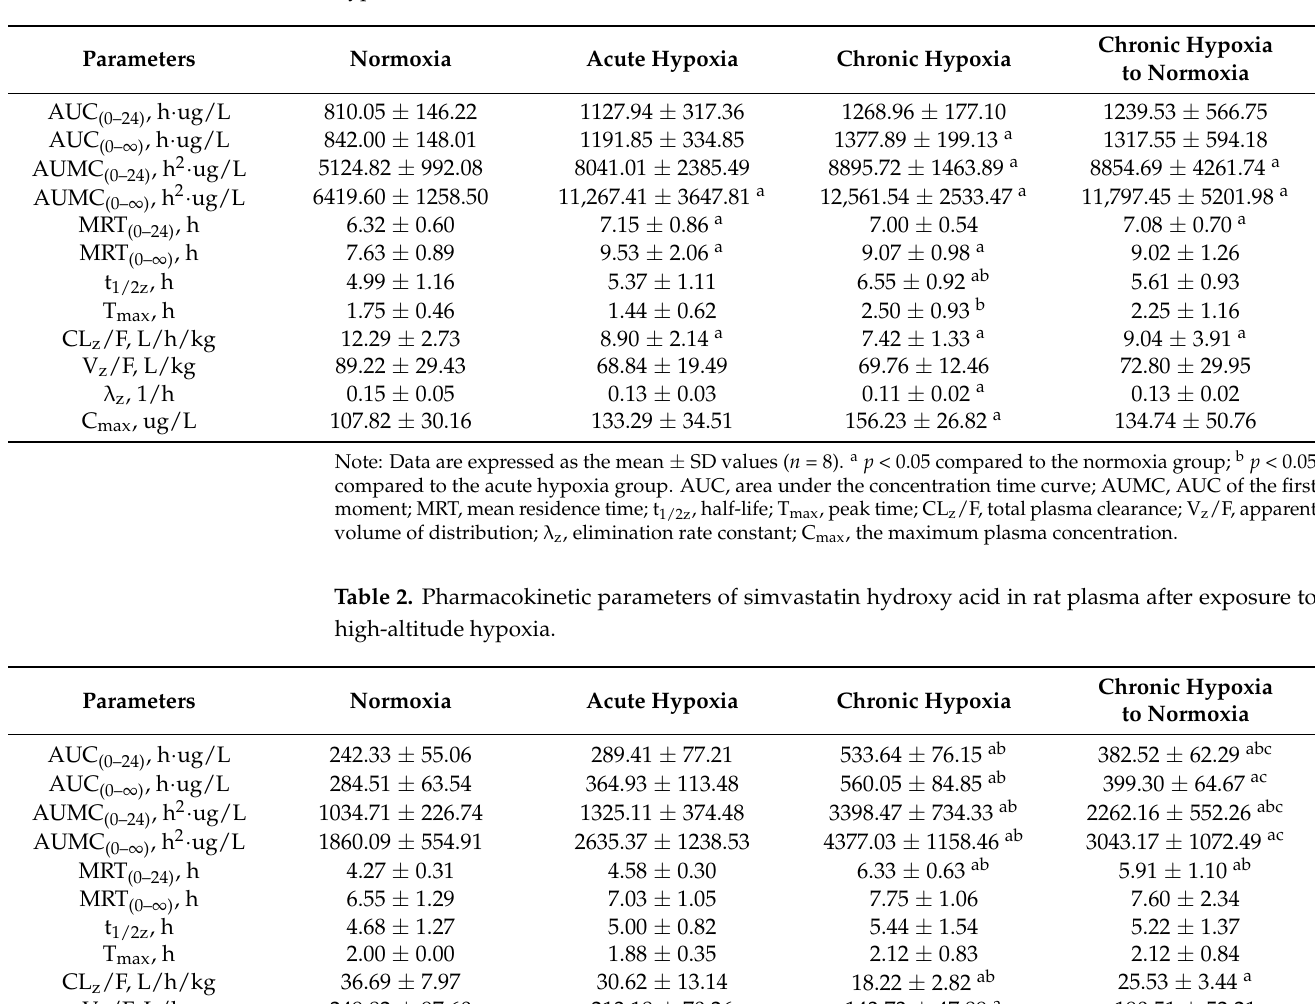
Table 1. Pharmacokinetic parameters of simvastatin in rat plasma after exposure to high-altitude hypoxia.